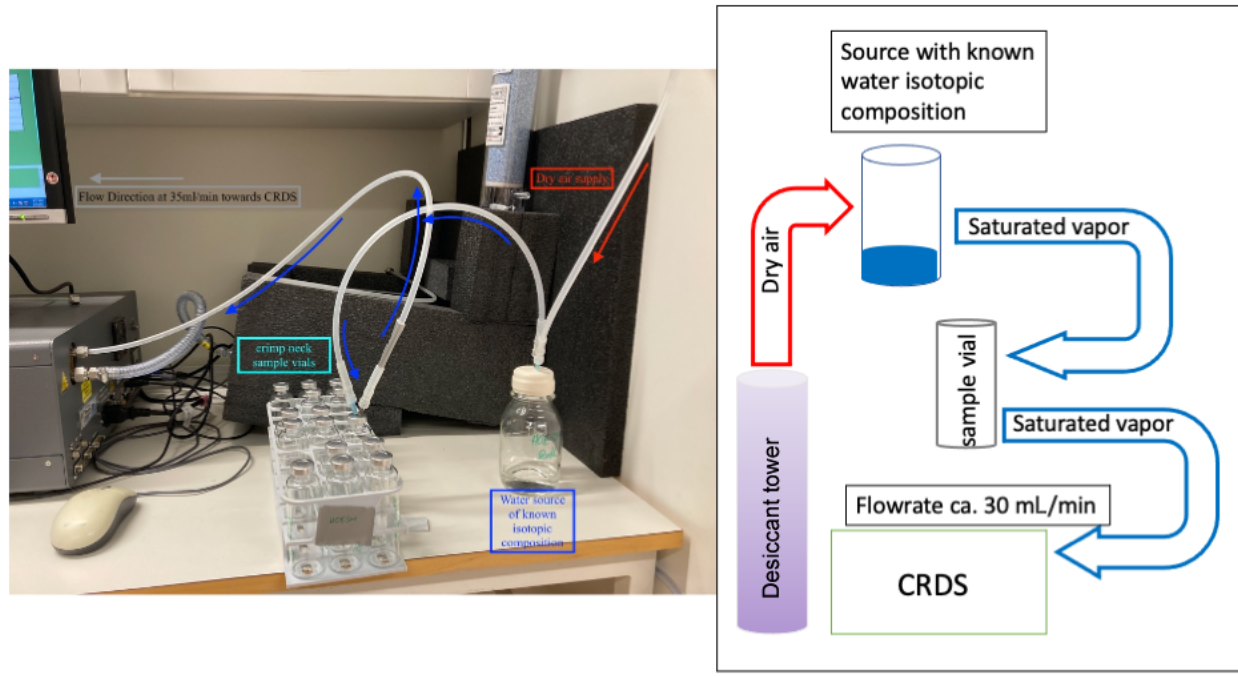
Figure 1. Setup of sampling in the lab experiment. The CRDS creates suction from the headspace of a water source of known isotopic signature (dark blue) into the crimped vials (turquoise). Pressure deficit is compensated for by air from a desiccant (Drierite ® ). The right side of the figure includes the same setup, this time as a schematic plan to improve readability. The isotopic composition and the water vapour concentration are monitored for 10min before the vial is disconnected from the flow and stored for later